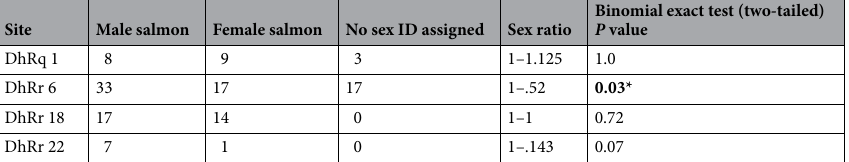
Table 2. Summary of sexed salmon by archaeological site irrespective of species. Statistically significant results at a α = 0.05 level of significance are in bold font and marked with an asterisk.